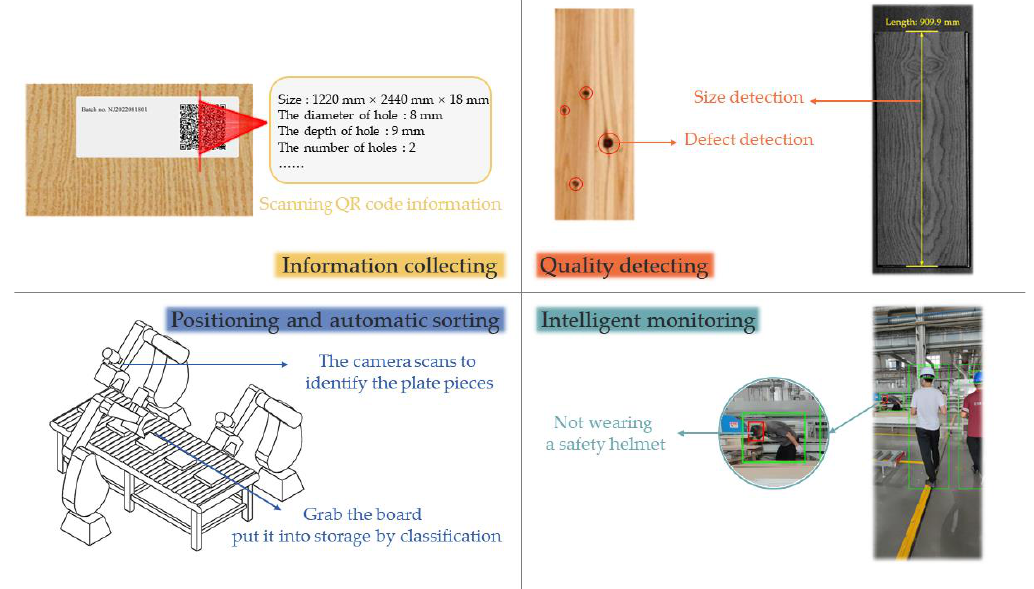
Figure 2. Applications of MV in furniture manufacturing workshop.